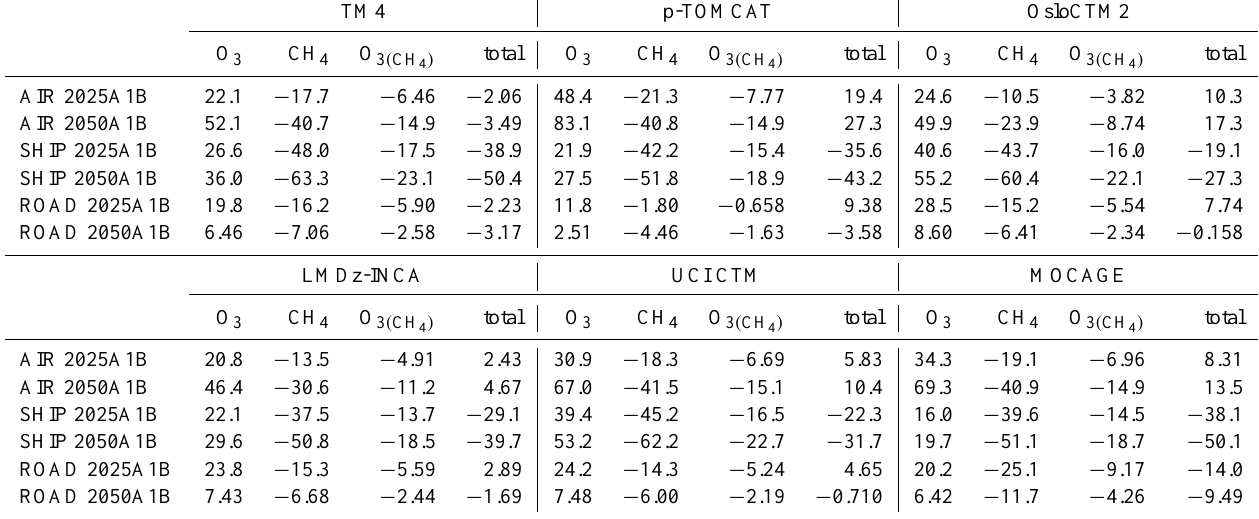
Table A2. Radiative forcings (mWm − 2 ) from changes in ozone, methane (including stratospheric water vapour), and methane-induced ) for different transport sectors and years. Note that the history of emissions has been taken into account, and that the fully ozone (O 3 ( CH 4 ) scaled perturbations were